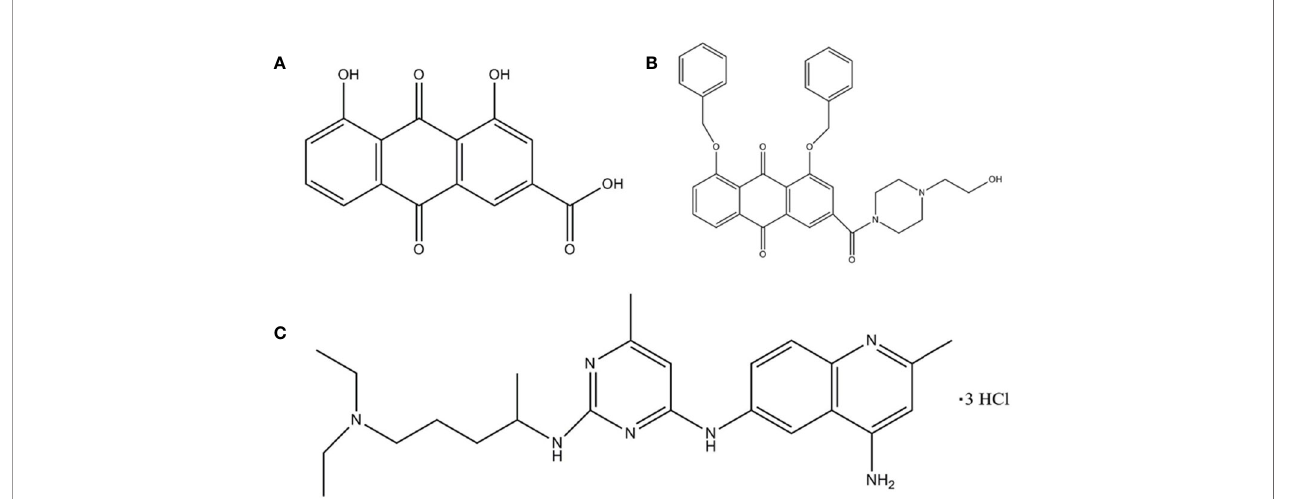
FIGURE 1 | The structure of the ligand molecules drawn in Chem Of fi ce Ultra 12.0 software. Both Rhein acid and derivative 4F contain an anthraquinone ring, while derivative 4F and NSC23766 contain nitrogen heterocyclic rings in common. Molecular structure of (A) Rhein, (B) derivative 4F, and (C)